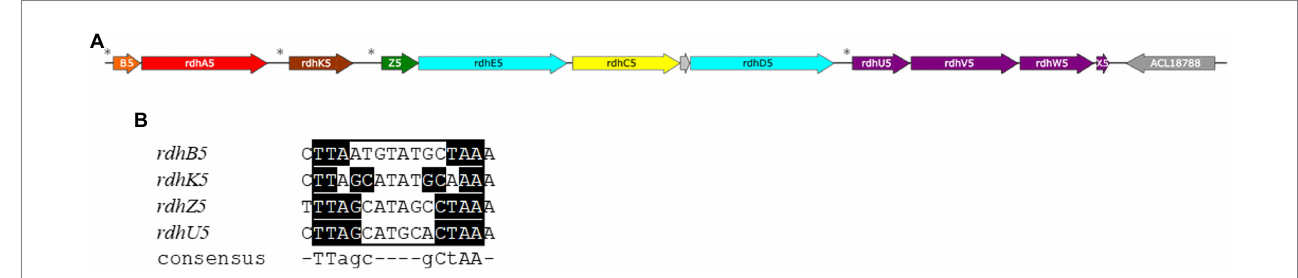
FIGURE 7 The reductive dehalogenase ( rdh ) gene cluster 5 from Desulfitobacterium hafniense strain DCB-2 (loci ACL18776-87). (A) Map of the gene cluster consisting of four putative transcriptional units: rdhBA , rdhK , rdhZECD and rdhUVWX . (B) Identification of partially conserved DNA motifs, so-called dehaloboxes, Gábor et al. (2006) upstream of each transcriptional unit, as indicated by the stars in panel A, that are targets of the transcriptional activator protein, RdhK5. (Note: a short additional locus was predicted between rdhC5 and rdhD5 (ACL18782, grey arrow), without any evidence that it codes for a protein.)